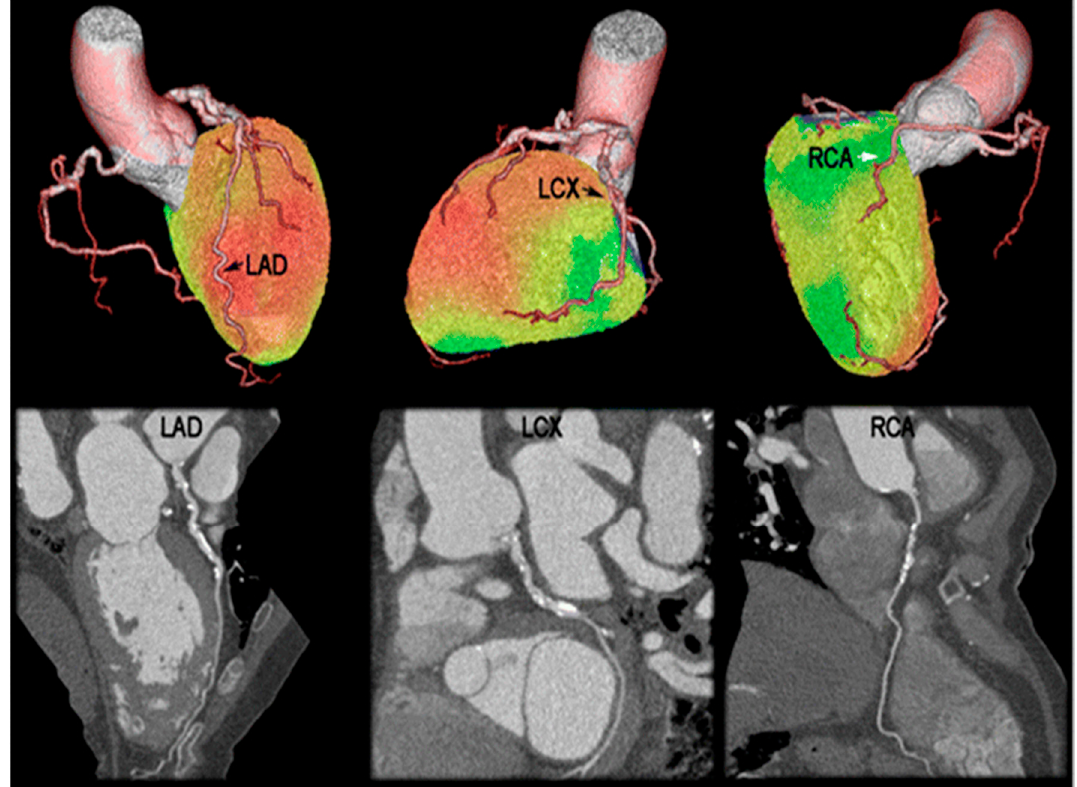
Figure 3. PET/CT assessing perfusion and coronary artery anatomy. Hyperemic MBF by PET ( top ) was reduced in the territories supplied by the left circumflex artery (LCX) and right coronary artery (RCA) (1.8–1.9 mL/min/g), but normal in the left anterior descending (LAD) arterial territory (2.6 mL/min/g). CCTA interpretation ( bottom ), however, suggested significant stenoses in the LAD, LCX and RCA. Adapted from Thomassen et al., 2013, by permission of Eur. J. Nucl. Med. Mol. Imaging [96].